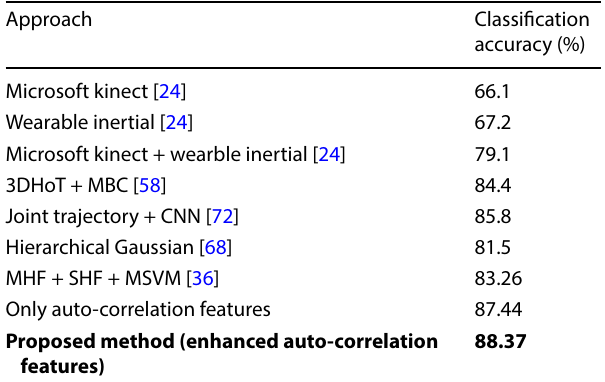
Table 5 Performance of our method compared to the existing sys- tems in terms of the UTD-MHAD dataset